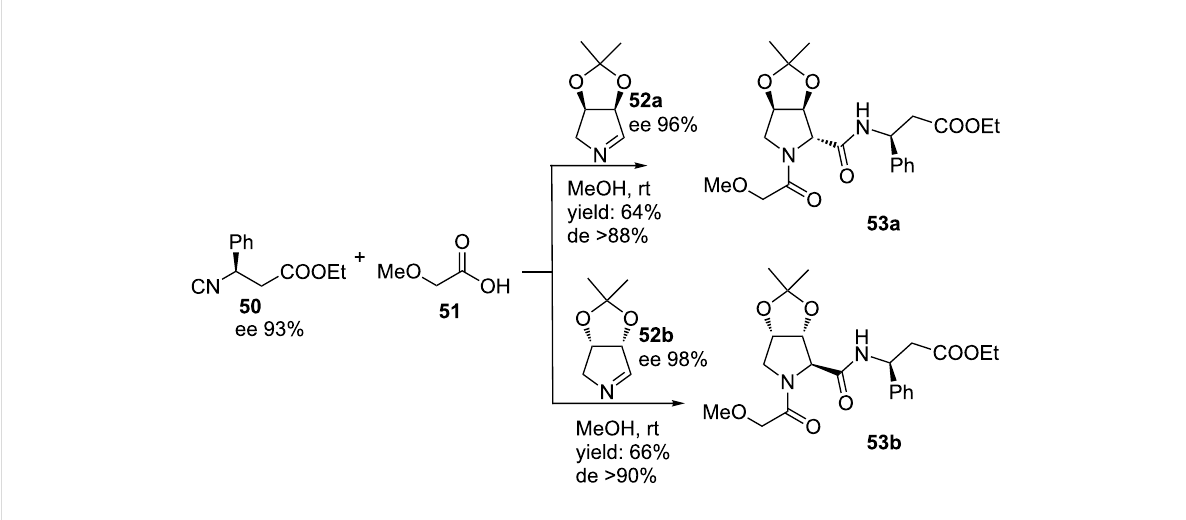
Scheme 16: Diastereoselective Ugi reaction described by Banfi and co-workers.